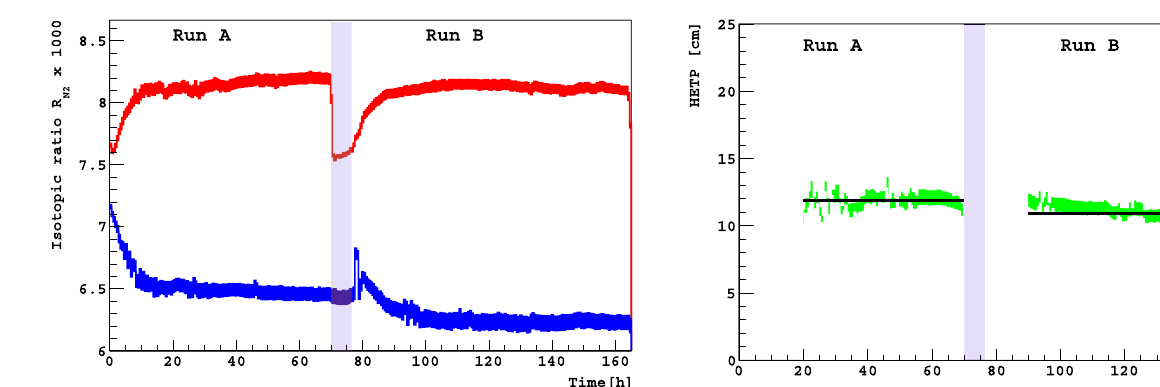
vs. Fig. 18 HETP vs. time for 29 N 2 – 28 N 2 distillation in the prototype 2 plant. The green band represents the combined systematic uncertainty from the spectrometer calibration (largely dominant) and the rela- tive volatility. The lower range corresponds to the additive correc- tion while the upper range corresponds to the multiplicative one. The horizontal lines indicates the HETP values in Run A and Run B of 12 . 6 ± 1 . 4cmand11 . 6 ± 1 . 2cm,respectively,calculatedaveragingthe values obtained with the two calibrations. The statistical uncertainty is added in quadrature to the mean half-difference of the HETP obtained from the two